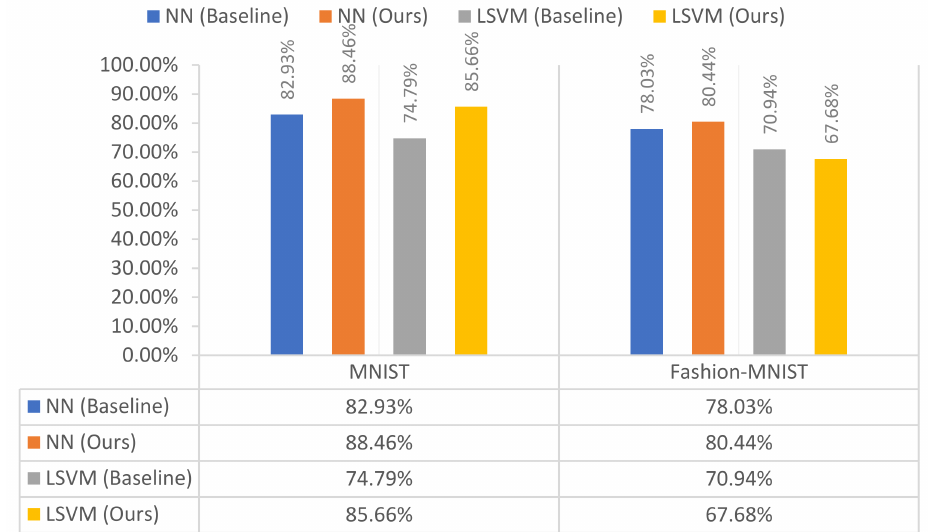
Figure 5. Set-1 pilot experiment accuracies on the MNIST and Fashion-MNIST datasets. In Set-2 of the pilot experiments, we compared two options. Option 1 was using the reconstructions of the third module as input to the classifier versus the original input data (as demonstrated before). Option 2 was proceeding to the applied classifier with the output of the second module, which were the latent representations obtained from the regressors, versus using the latent representations obtained directly from the autoencoder. Results for semi-supervised clustering and classification are shown in Tables 6 and 7, respectively. Bolded values indicate the best results obtained in each metric except for Inertia where bolded value indicate the best results obtained for each option separately as Inertia is not a normalized metric. The results show that Option 1 is slightly better than Option 2 in most cases in both semi-supervised and supervised settings. In addition, the reconstruction option has the added privilege of not interfering with any subsequent machine learning task. Because the output is of the same dimensionality and nature of the input data, (i.e., no changes are needed for the baseline classification and clustering model setups). Table 6. Set-2 pilot experiment semi-supervised clustering setting results. D Ts is the original unlabeled test set (without transformation), ˆ D Ts is the transformed (using our model) unlabeled test set. Z ts and ˆ Z Ts and the transformed ts are the features extracted from the autoencoder of the original test set D test set ˆ D Ts , respectively. Bolded values indicate the best results achieved in each